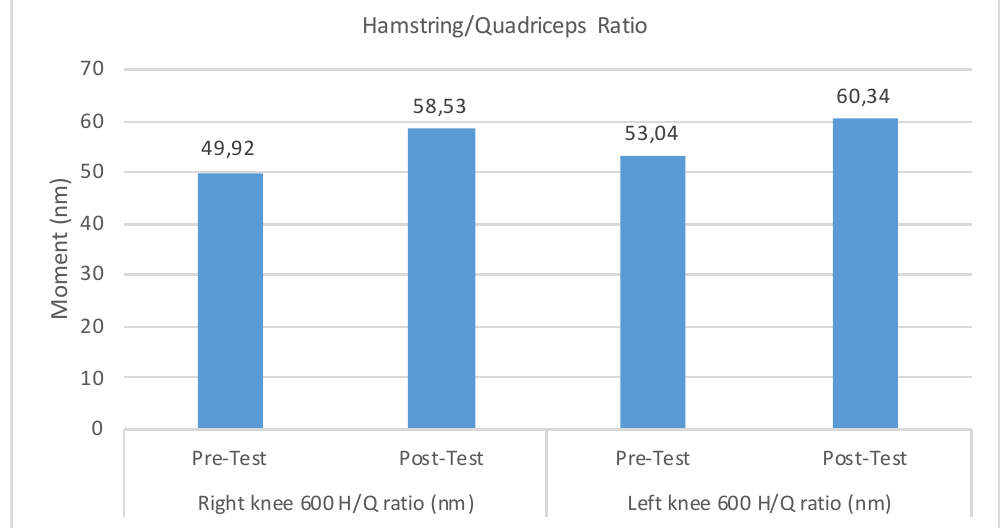
Figure 2. Football group pre-test and post-test H/Q ratio